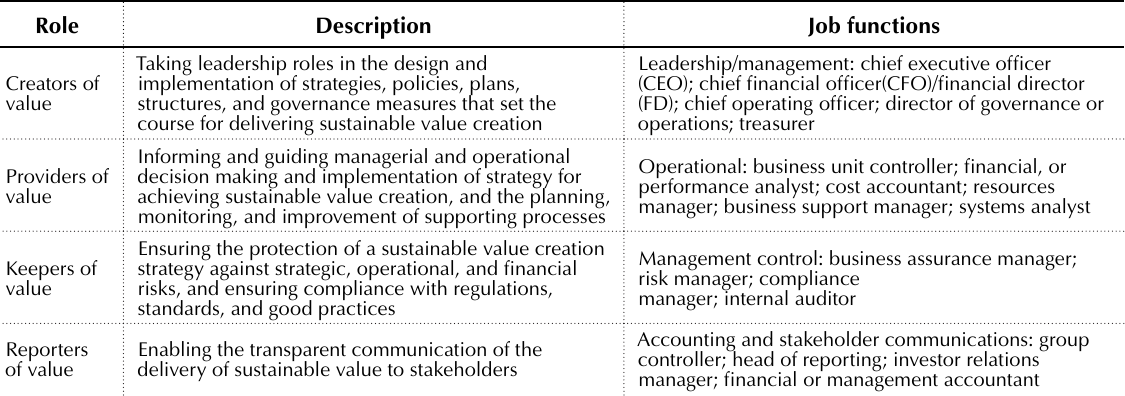
Table 3. Key roles of professional accountants in sustainable business (IFAC (2011), IFAC